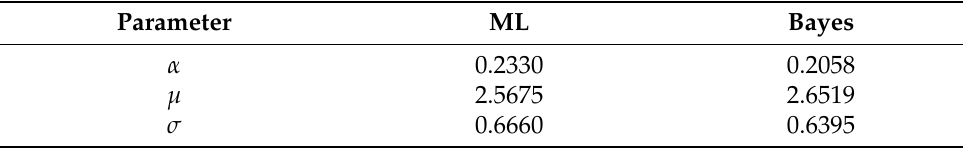
Table 13. MLEs and Bayes estimates of the GDUSLN parameters on bladder cancer dataset.